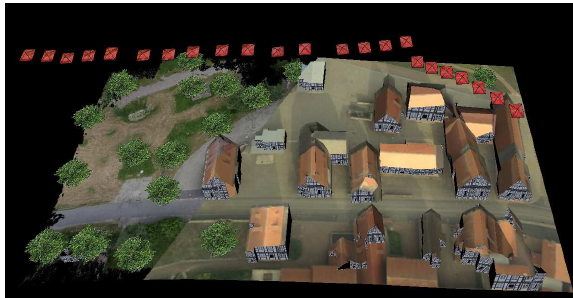
Figure 9: A view of the textured model from the data set Bonn- land . Camera positions corresponding to the reference images are depicted by red viewing cones while the image on the left of Fig.2 is used to texture the terrain and building roofs. A typical facade for the region is used to texture building walls. The trees are modeled in the elevated tree-like pixel areas of Fig.2.